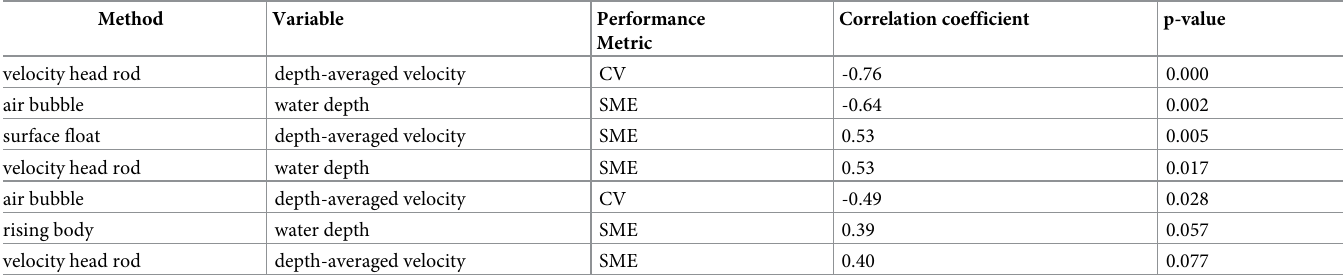
Table 3. Correlations between the performance metrics (CV and SME) and the stream variables (water depth and depth-averaged velocity) for each alternative velocity method.